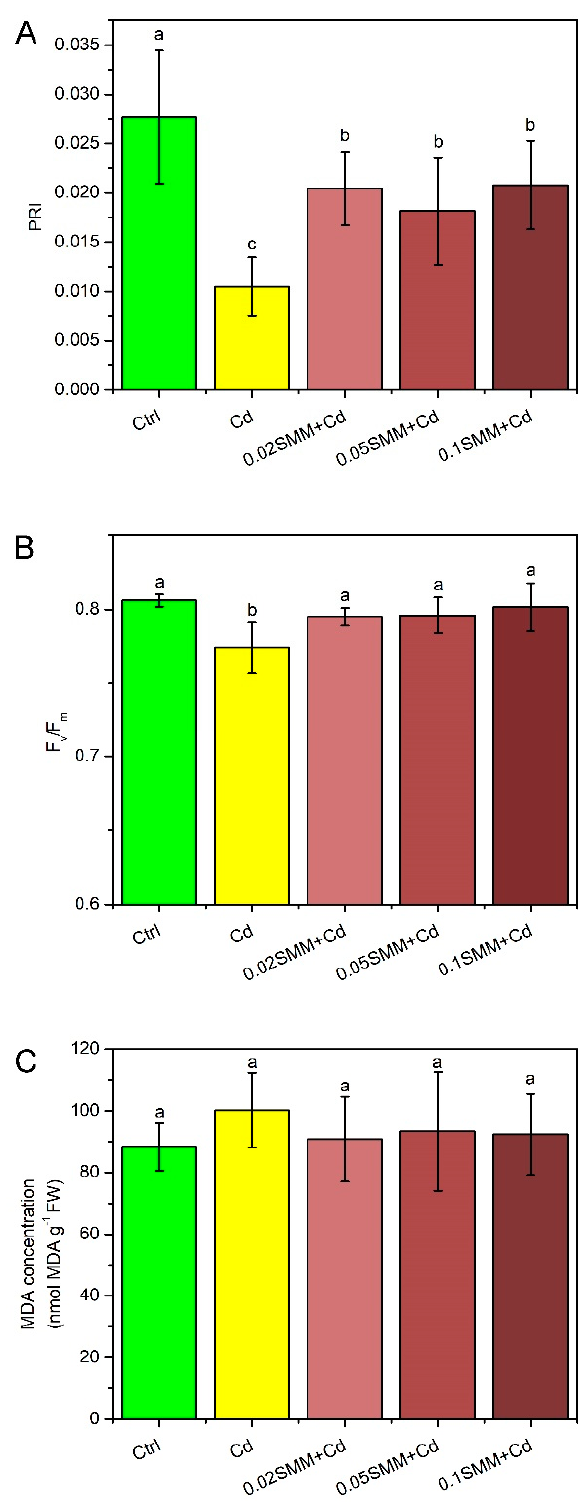
Figure 3. Photochemical reflectance index (PRI) ( A ), maximal quantum efficiency of PSII reaction centers (F v /F m ) ( B ) and MDA concentration ( C ) in the youngest fully developed leaves of Szarvasi-1 energy grass primed with 0.02, 0.05 and 0.1 mM SMM and exposed to 0.01 mM Cd. To compare the differences, one-way ANOVA was performed on each dataset combined with Tukey–Kramer post hoc test on the treatments ( p < 0.05). Different lowercase letters indicate significantly different